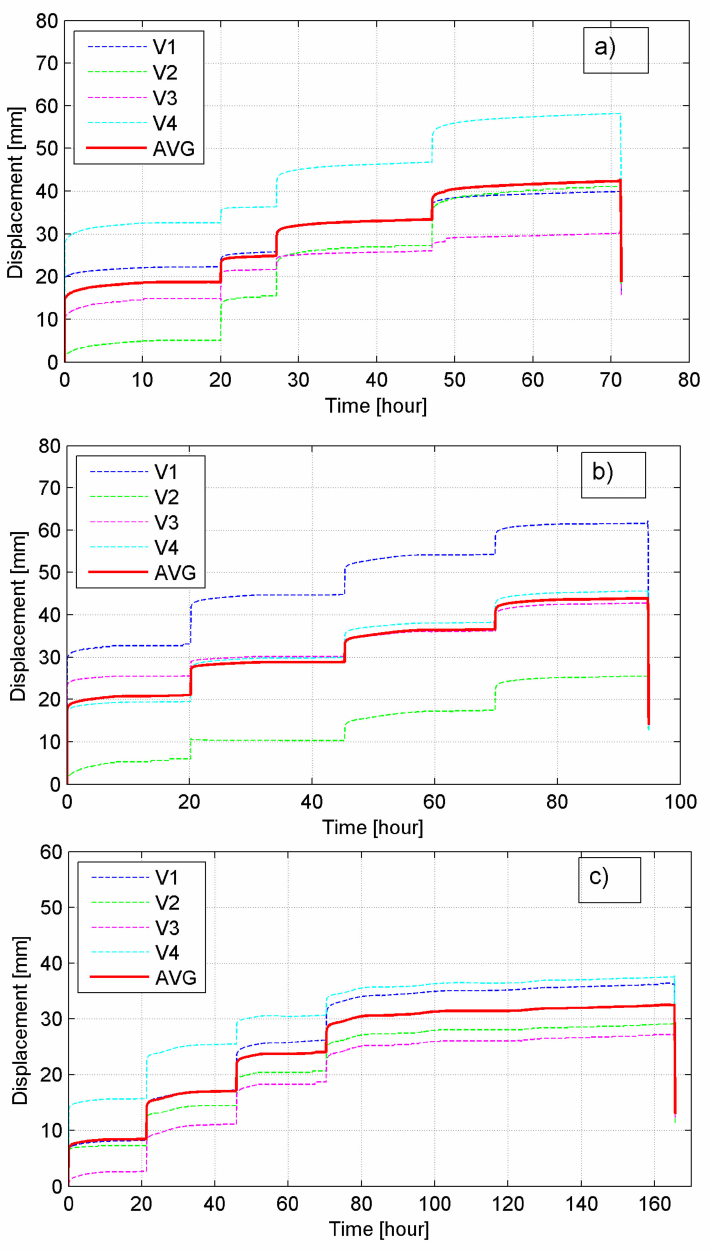
Figure 23. Creep curves for: ( a ) P-1 specimen; ( b ) P-2 specimen; ( c ) P-3